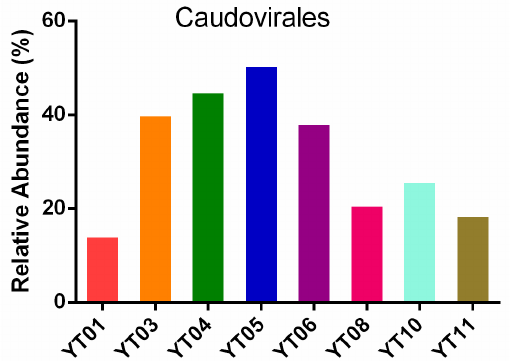
Figure 1. Relative abundance of Caudovirales in different algal blooming samples.